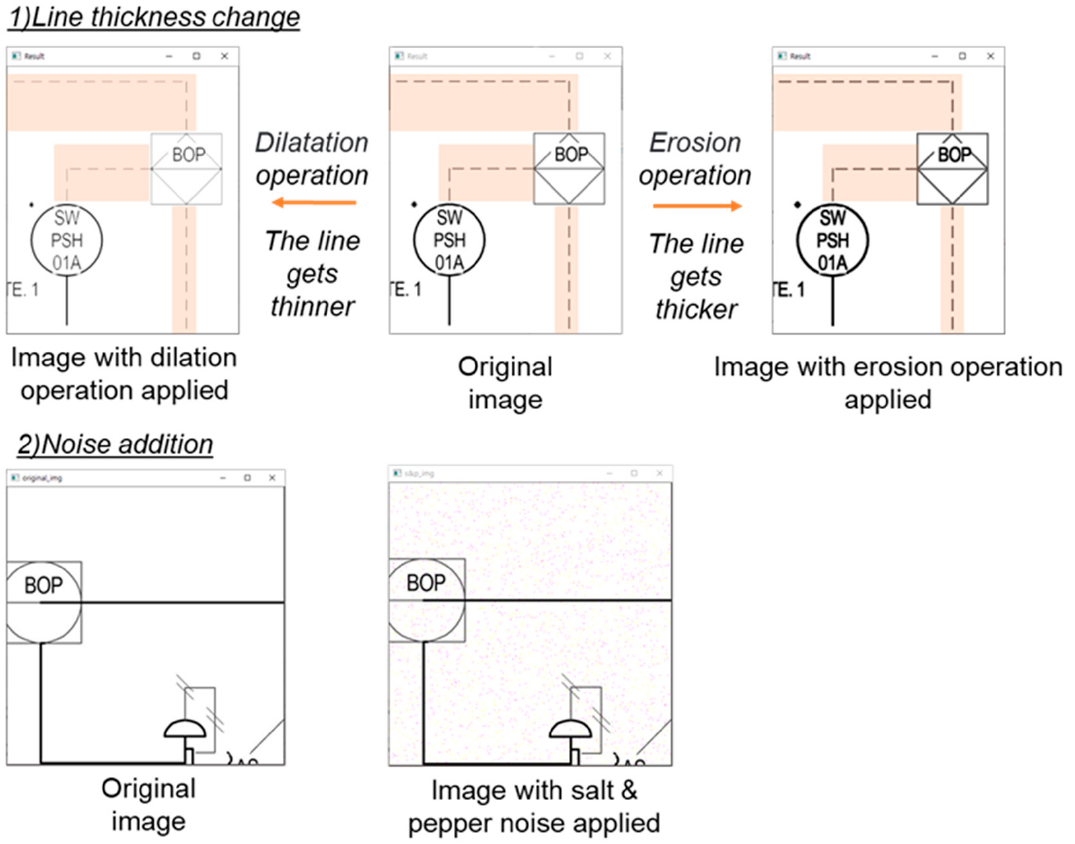
Figure 8. Image modification for training data augmentation.